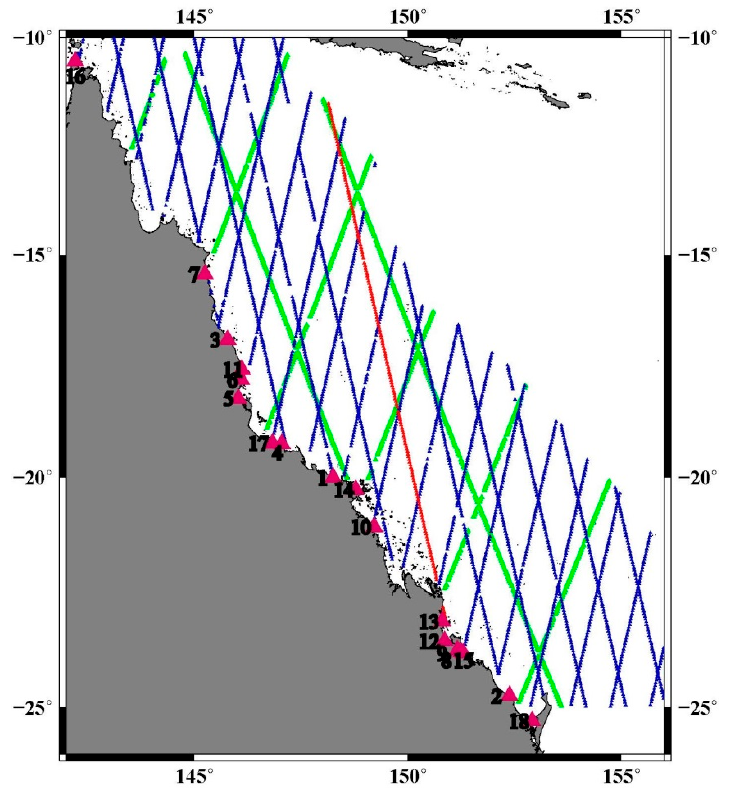
Figure 2. The geographical coverage of coastal tide gauges along the coastline (pink rectangles), the main T/P orbits over the GBR (green tracks) and Sentinel-3A ground tracks (dark blue tracks). The red line (pass 731) is used to assess the performance of the models for tidal height prediction with respect to distance from the coast and bathymetry.